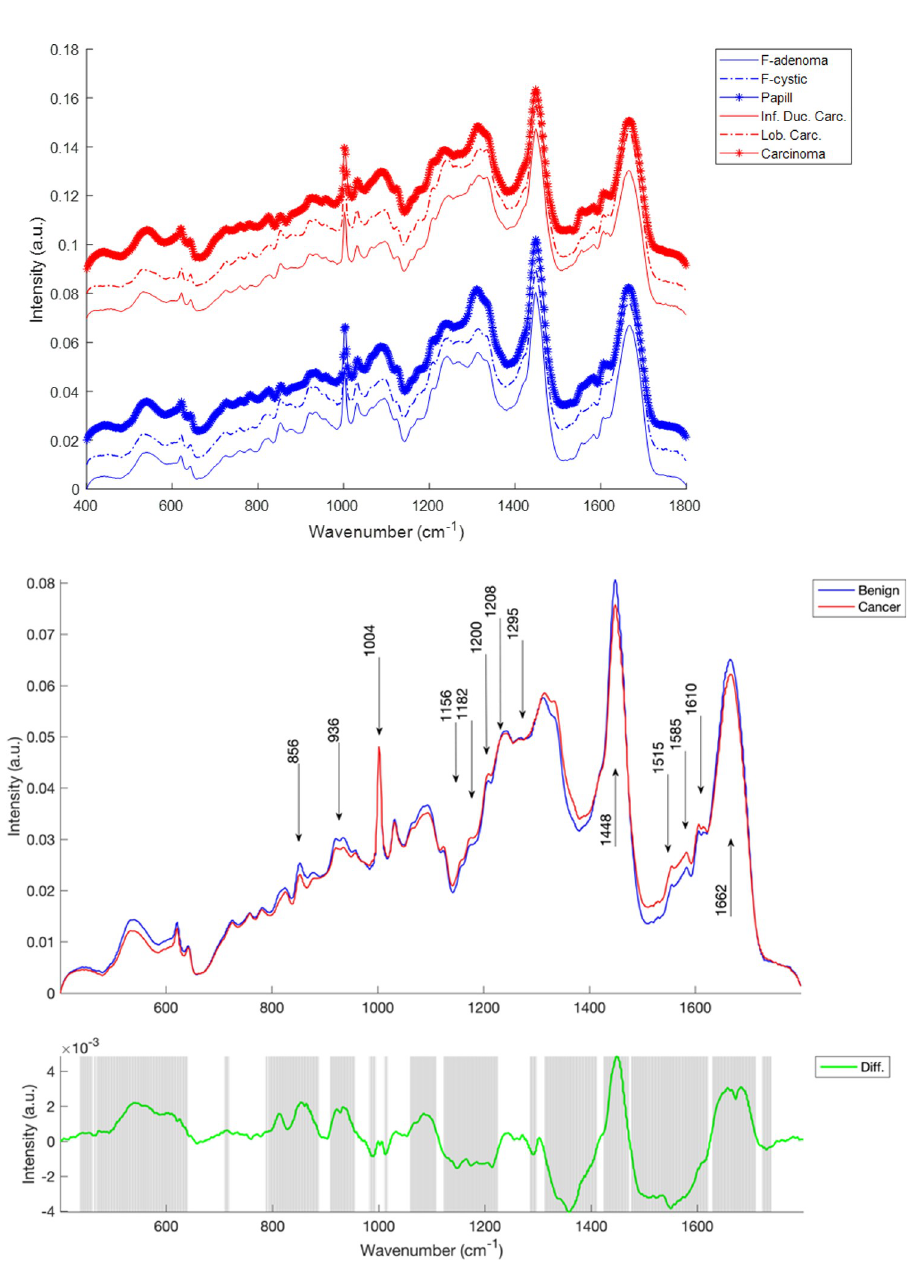
Fig 3. Top panel, mean spectra by subclass, with benign tissues (fibrocystic adenoma, fibrocystic disease and intraductal papilloma) in blue and cancerous tissues (infiltrating ductal carcinoma, infiltrative lobular carcinoma and carcinoma) in red. Spectra are offset for clarity. Middle panel, mean spectra of benign (blue) and cancerous tissue (red), Bottom panel, difference spectrum (green) and shaded regions in which a 2-tailed t-test has identified differences that are significant at the level of p < 1 × 10 − 4